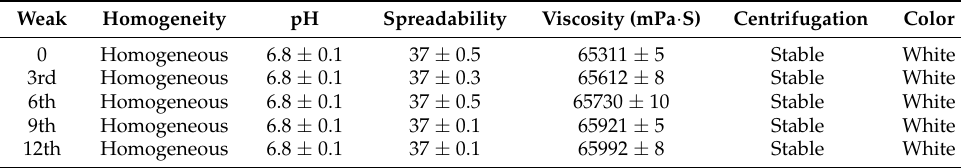
Table 8. Stability of nanoemulgel at room temperature (25 ◦ C).